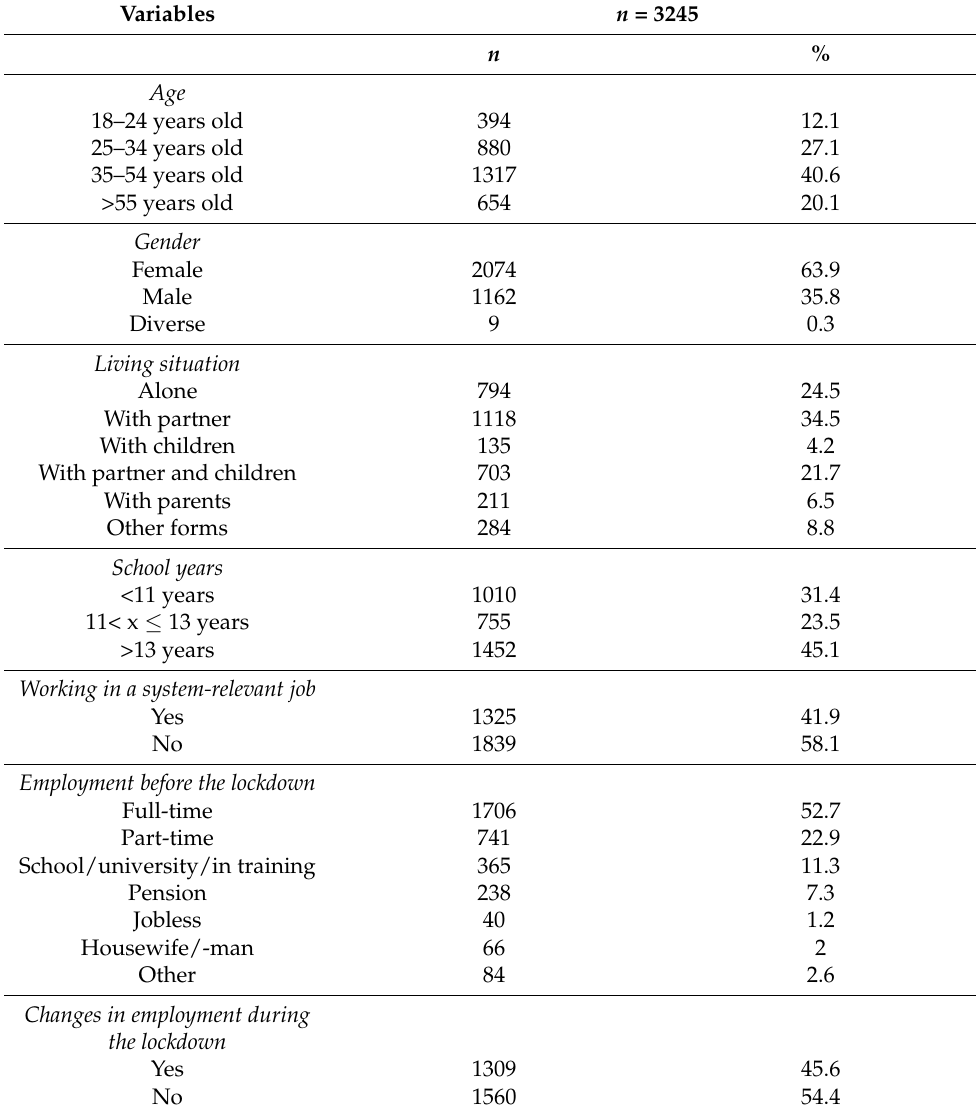
Table 1. Demographic data of the